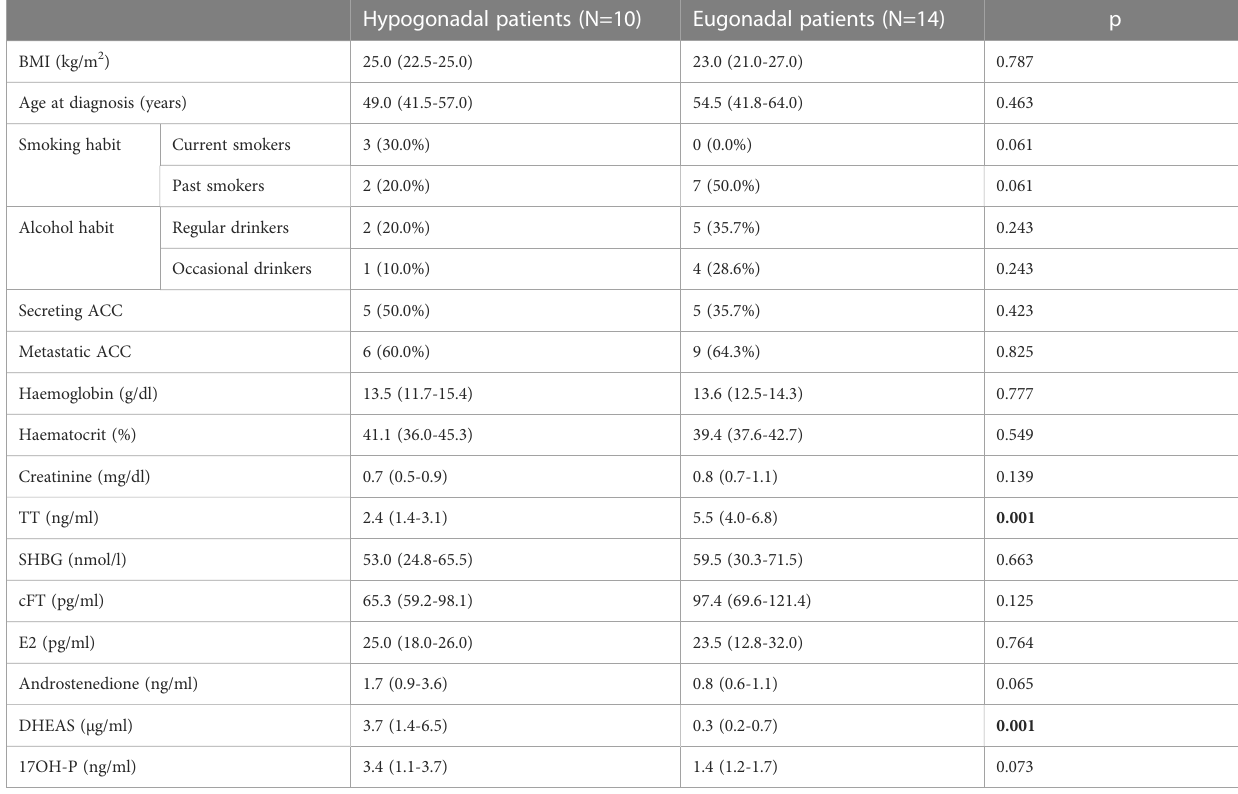
TABLE 2 Comparison between hypogonadal and eugonadal patients prior to the start of